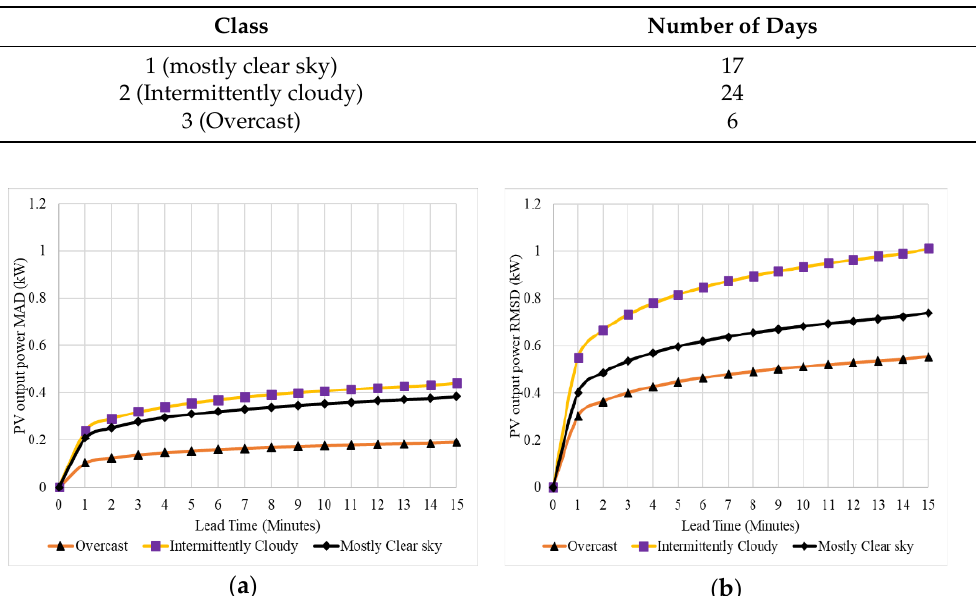
Table 7. Distribution of days under analysis.